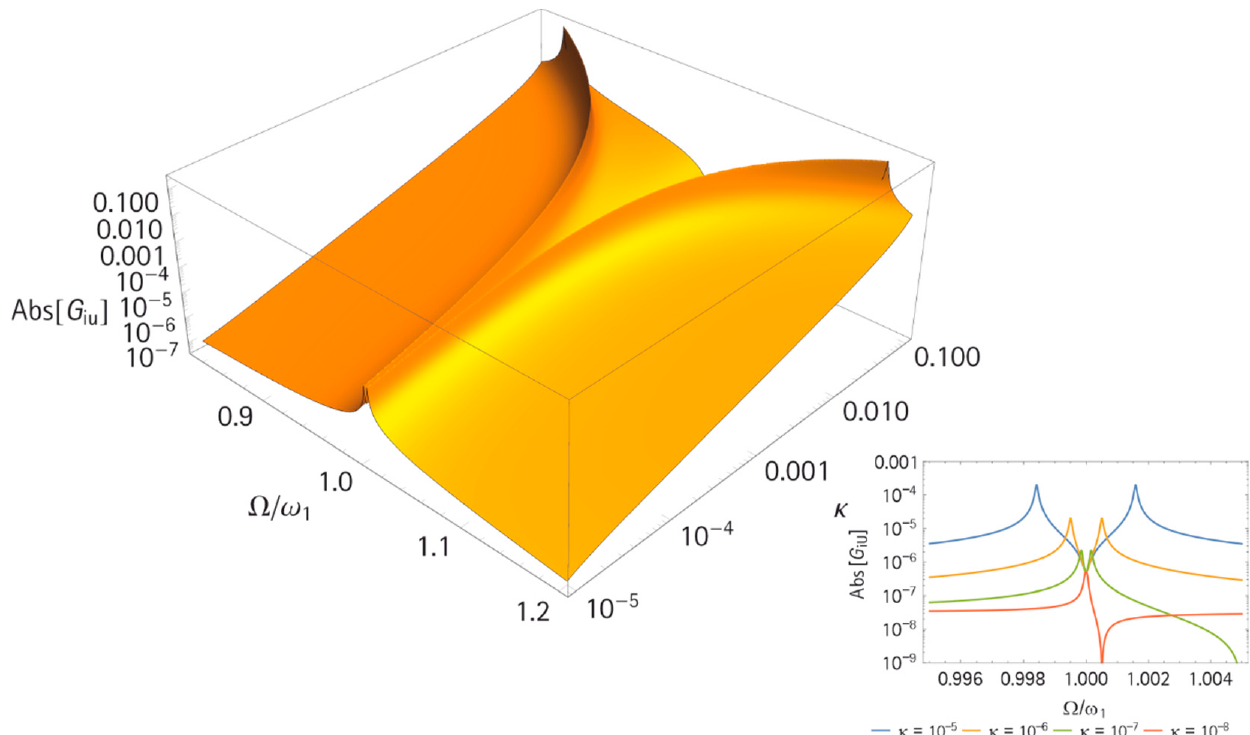
Figure 5. Frequency response for (cid:1833) 1 kg, m n = 0, k = 10 N/m, M = 10 4 kg, k M = 10 5 N/m, D = d M = 5x10 − 4 Ns/m, C p = 10 nF, and α = 0.1 N/V.